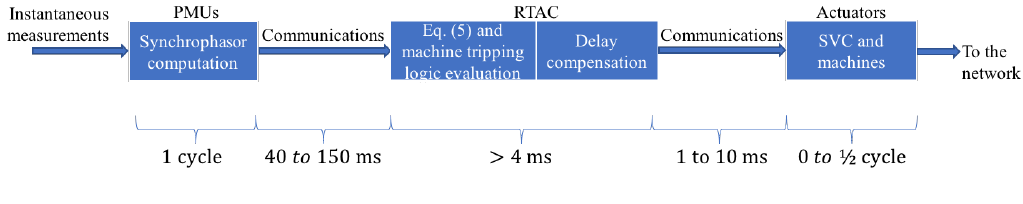
Figure 7. Implementation delays on the WAC-SVC and the generator tripping